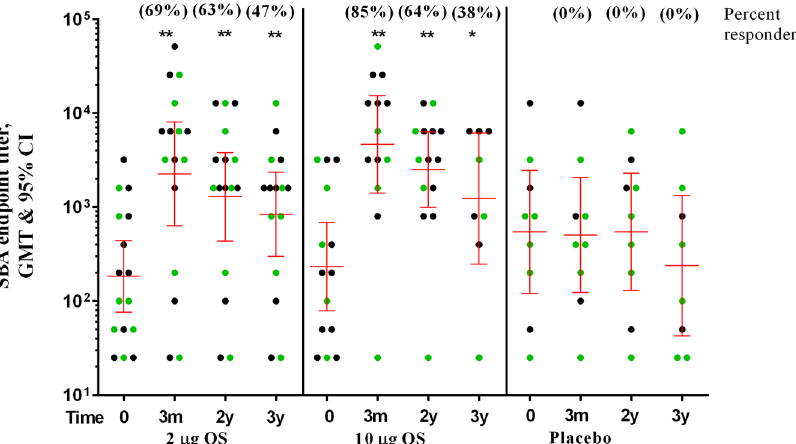
Fig. 2 Longevity of SBA GMT (95% CI) in vaccinees receiving 2 or 10 µg OS doses of non-adjuvanted and adjuvanted SF2a-TT15 and in placebo recipients. Circles represent individual endpoint titers, green circles represent volunteers receiving the adjuvanted vaccine or placebo. Bars represent the geometric mean titres (GMTs) and the 95% Con fi dence Intervals (CIs) on day 0 (baseline), at 3 months, 2 and 3 years post-vaccination. Serum Bactericidal Activity (SBA): a serum dilution yielding at least 50% reduction in the number of colonies compared with control was de fi ned as having bactericidal activity. The last serum dilution with bactericidal activity was de fi ned as the endpoint titer. * p - value < 0.05; ** p -value < 0.01 (vs. day 0).